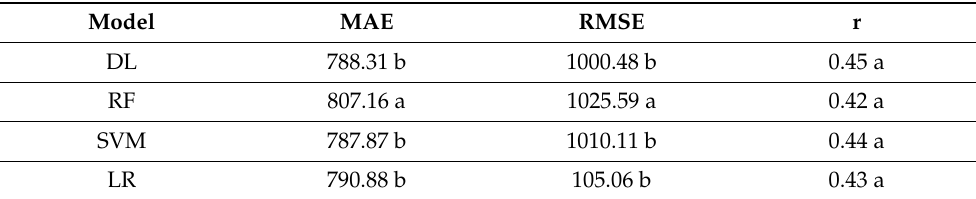
Table 4. Grouping of means of mean absolute error (MAE), root mean squared error (RMSE), and Pearson’s correlation coefficient (r) between estimated and observed values for grain yield in soybean obtained with different machine learning